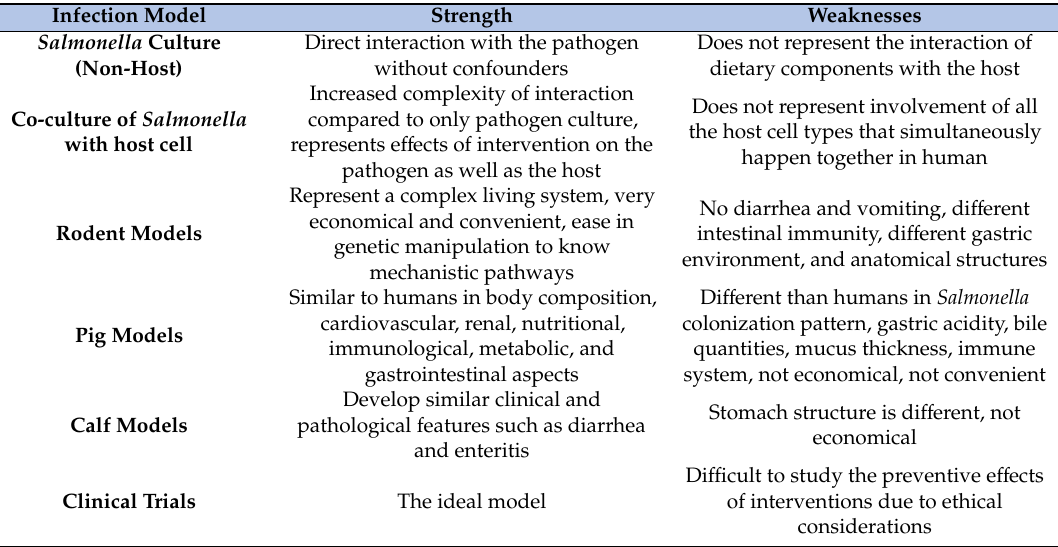
Table 1. Strengths and weaknesses of Salmonella models discussed in the current